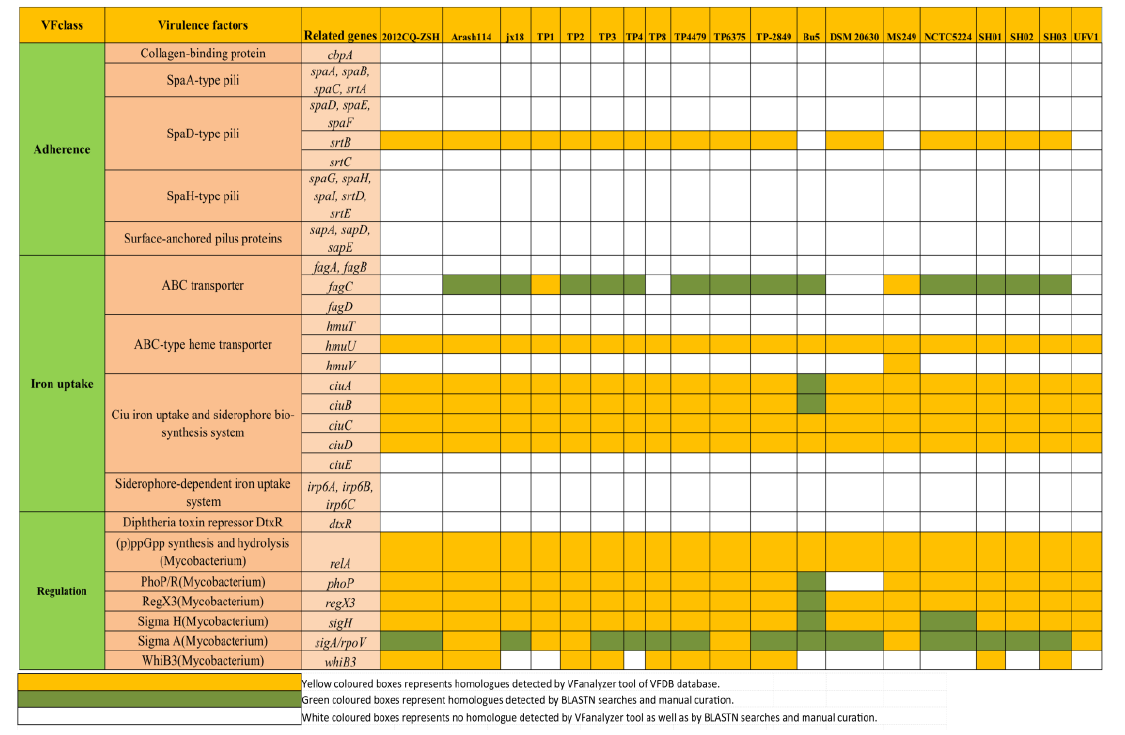
Figure 7. Presence/absence profile of virulence genes homologues aka candidate virulence factors (CVF’s) across the T. pyogenes genomes by utilization of the VFanalyzer tool of the VFDB database, BLASTN searches, and manual curation. Yellow colored boxes represent CVF detected by the VFanalyzer tool of the VFDB database. Green colored boxes represent homologues detected by BLASTN searches and manual curation. White colored boxes represent no homologue detected by VFanalyzer tool or BLASTN search.